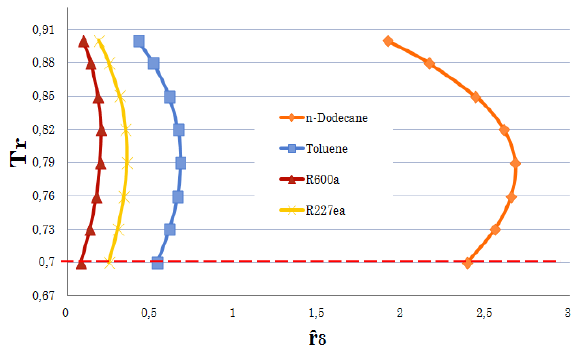
Fig. 3. Lambrakis’ parameter for different working fluids